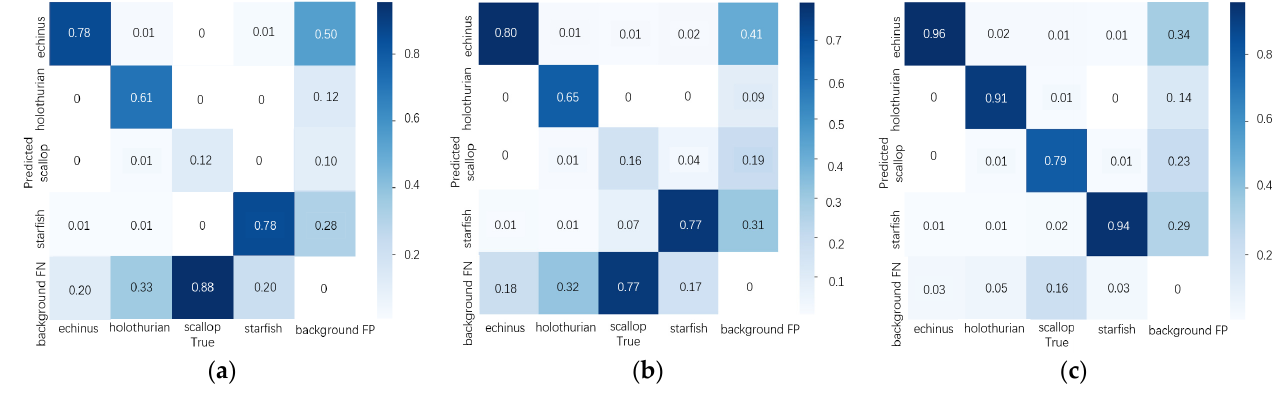
Figure 22. The confusion matrices based on the inferencing test results: ( a ) YOLOv5; ( b ) proposed model; and ( c ) proposed framework.